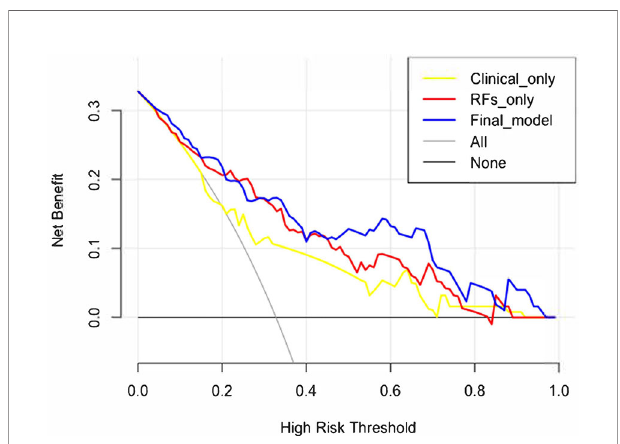
FIGURE 7 | Decision curve analysis results of the clinical variables-only model, RFs only model, and fi nal